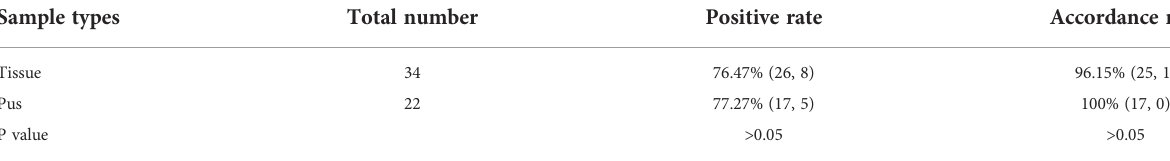
TABLE 5 Comparison of the diagnosis ef fi ciency of tissue and pus samples by